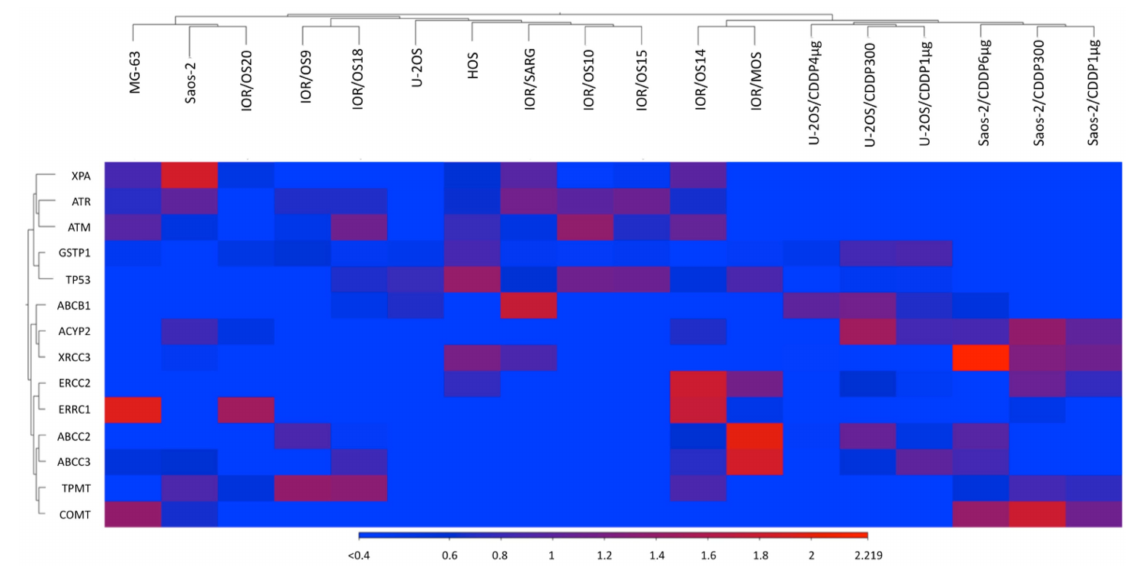
Figure 8. Heatmap plus hierarchical clustering analysis of 12 drug-sensitive and 6 cisplatin (CDDP)- resistant human osteosarcoma cell lines generated from RNAseq data using the CLC Genomics Workbench (GWB)